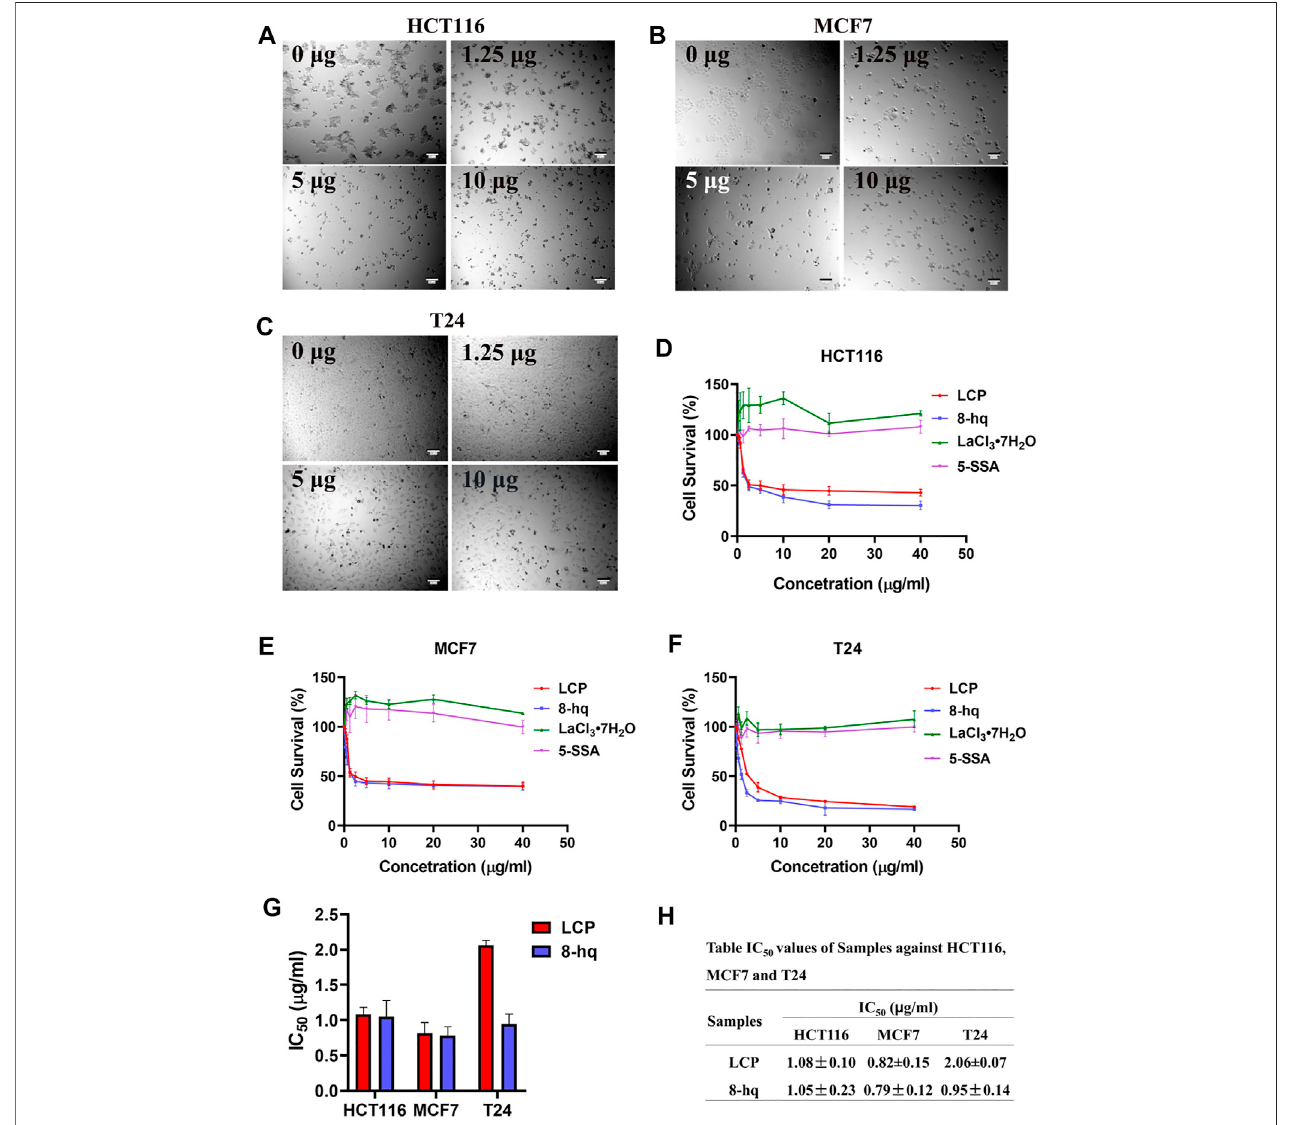
FIGURE7| Tumorcellsurvivalrateofcomplexandligands.Thetumorcellmorphologyunderthemicroscopeatdifferentconcentration(0 μ g/ml,1.25 μ g/ml,5 μ g/ ml, and 10 μ g/ml) of LCP-1 (A – C) , CCK-8 assay showed that the LCP and ligands inhibit the growth of HCT116, MCF7, and T24 cells (D – F) , and calculation of IC 50 of LCP and 8-hq in HCT116, MCF7, and T24 cells (G,H) . Data presented as the mean ± SD, n = 3.